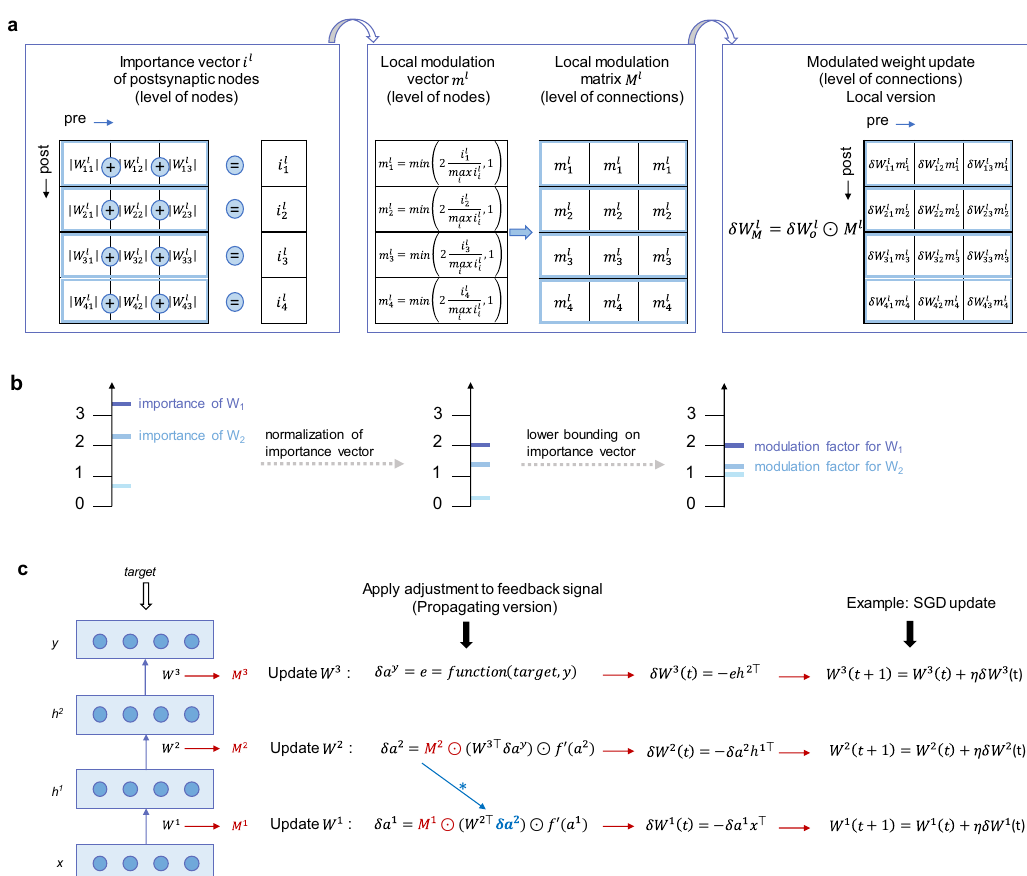
Fig. 2 Computation of the modulation factor. a The computation of the importance vector for one hidden layer, based on the associated weight matrix, is followed by the computation of the local modulation vector, based on the node importance. In the local version, GRAPES adjusts the weight update through the Hadamard multiplication of the initial weight-update matrix δ W l with the local modulating vector M l . b Sketch illustrating the steps in computing the o modulation factor using the importance vector in the simple case of three postsynaptic nodes. c Algorithm for the propagation of the modulation factor to the upstream layers in a two-hidden layer network. The activations in the network are computed as a 1 = W 1 x , h 1 = f ( a 1 ) and a 2 = W 2 h 1 , h 2 = f ( a 2 ), and the network output as a y = W 3 h 2 , y = f y ( a y ). Note that δ a 2 is adjusted through the modulation matrix M 2 and such adjustment also affects the upstream layer since δ a 1 contains δ a 2 fi lter importance. The fi lter update is modulated accordingly as described in Eq. (3).